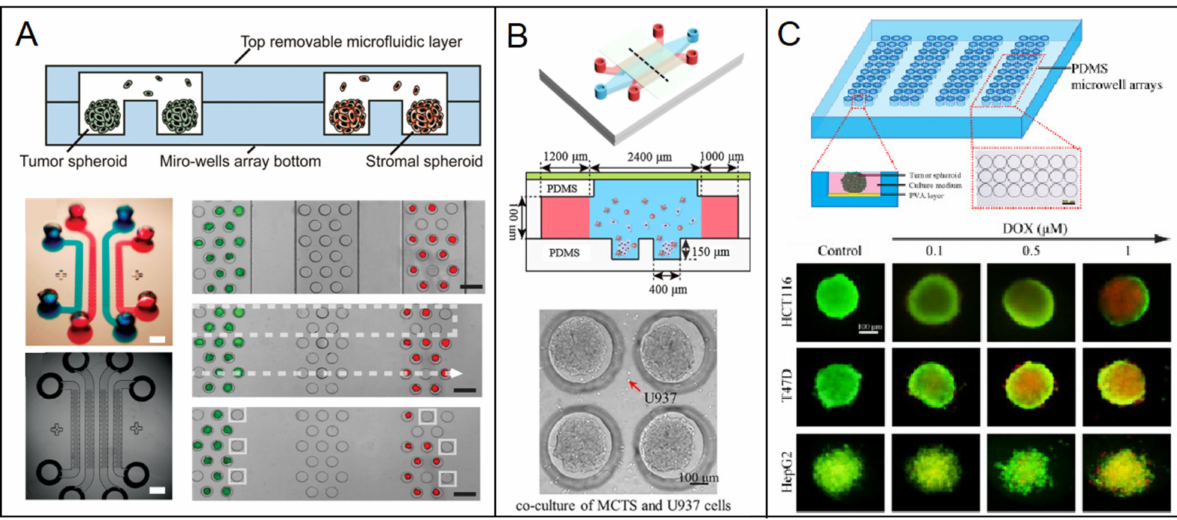
Figure 2. Diverse spheroids such as the breast models in a microfluidic chip. ( A ) Different cell spheroids of uniformly sized breast tumor cell of MCF-7 and fibroblast were prepared and systematic analyzed in a microfluidic device [12]. Open access. ( B ) Monocytes are co-cultured with low invasive low invasive T47D spheroids or high invasive MD-MBA-231 spheroids in a collagen matrix-embedded microfluidic device [17]. Reprinted with permission from ref. [17]. Copyright 2018 Chinese Academy of Medical Sciences. ( C ) A great number of uniform 3D tumor spheroids of breast cancer cell T47D were formed as well as other human cancer cell lines of HepG2 and HCT116 in a microfluidic chip for drug susceptibility testing [19]. Reprinted with permission from ref. [19]. Copyright 2015 Elsevier